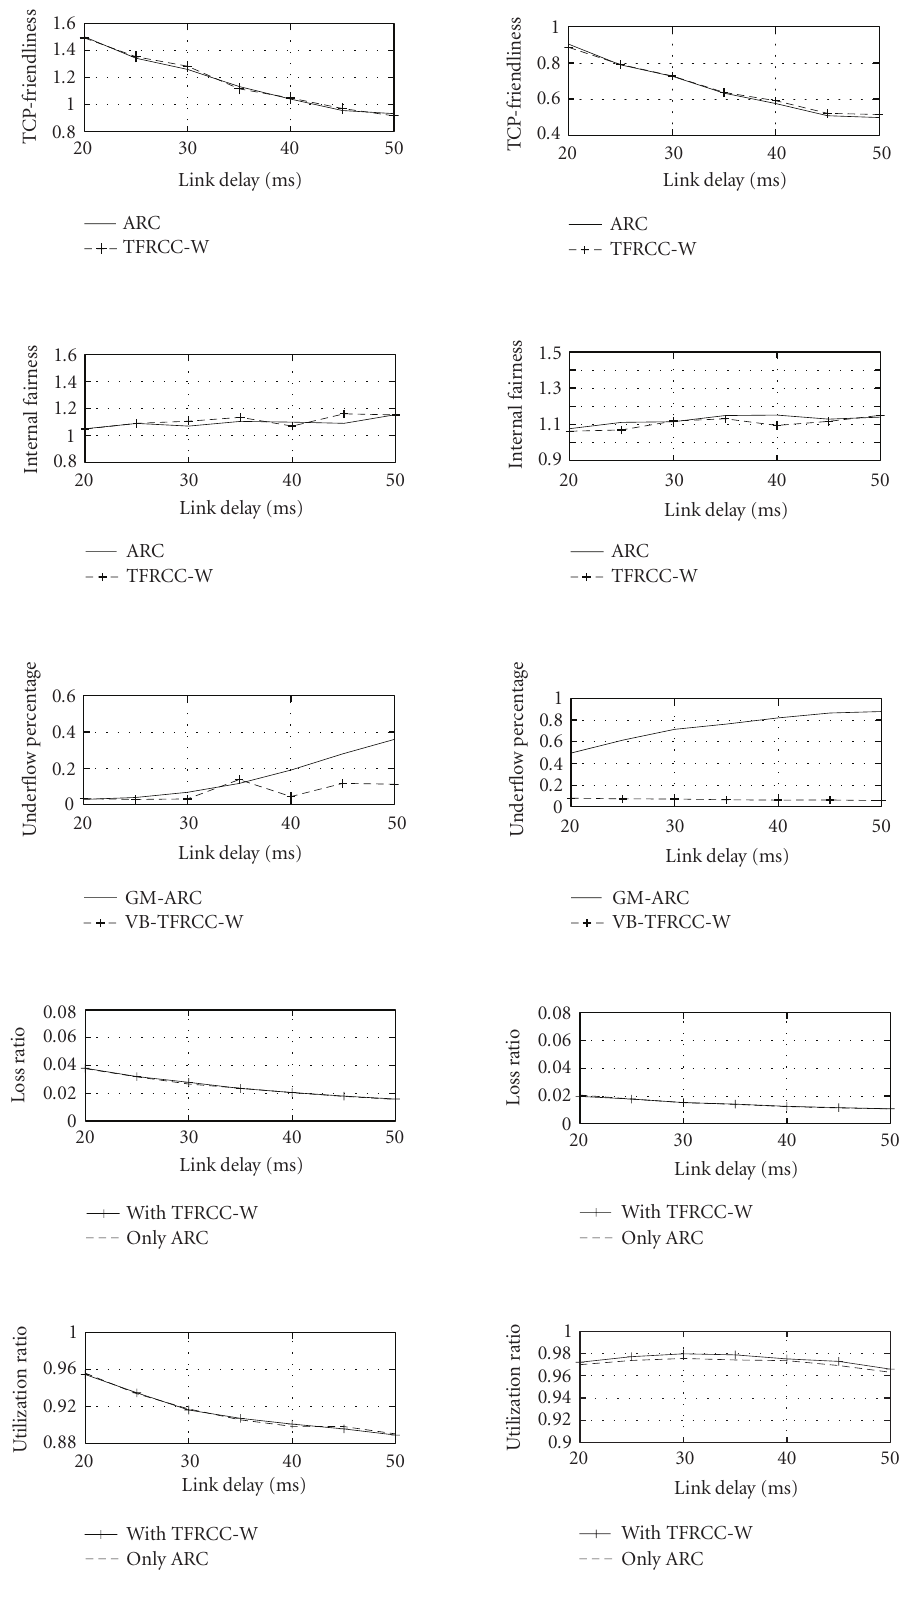
Figure 10: Overall system performance evaluation between GM-ARC and